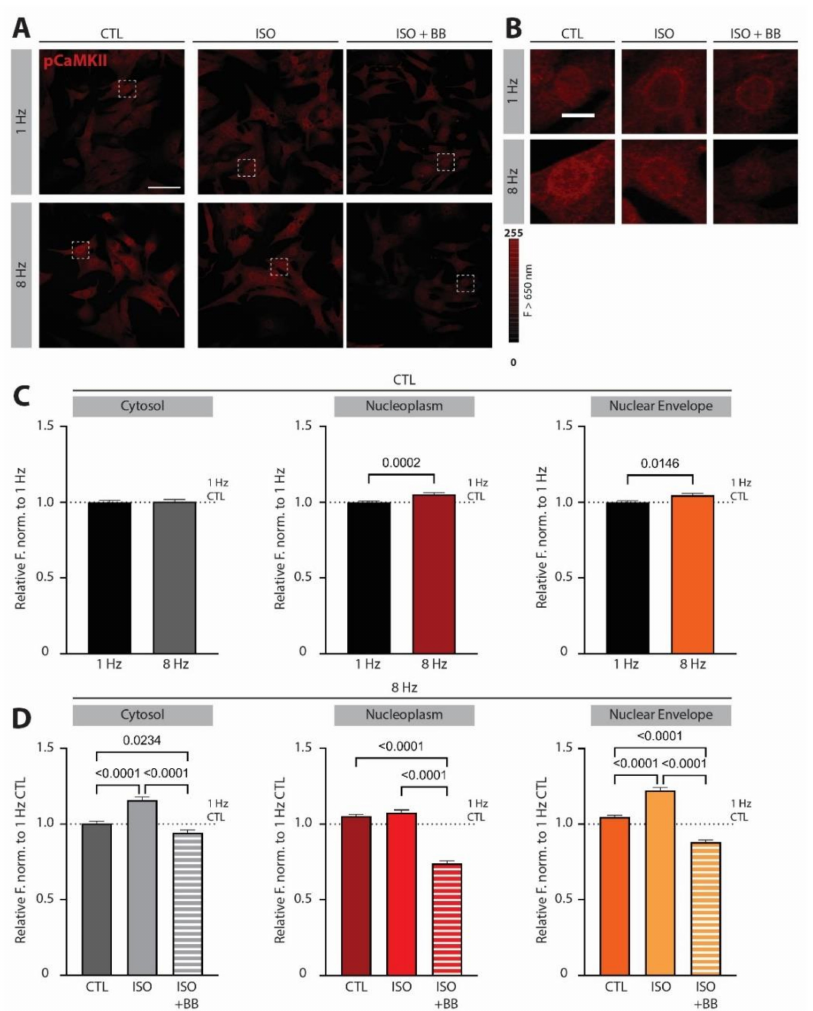
Figure 2. β -adrenergic signaling potentiates CaMKII activation on subcellular Ca 2+ stores in neonatal rat ventricular cardiomyocytes (NRVCMs) under conditions of tachypacing. ( A ) Rep- resentative fluorescent images of NRVCMs immunostained against phospho-CaMKII (pCaMKII) exposed to 3 h of either low pacing (1 Hz) or tachycardic pacing (8 Hz) frequency under control condi- tions (CTL), β -adrenergic stimulation with isoprenaline (ISO) or β -adrenergic stimulation following 1 h preincubation with β -blocker propranolol (ISO + BB). Scale bar indicates 50 µ m. ( B ) Magnified nuclei of indicated areas in ( A ). Scale bar indicates 10 µ m. ( C ) Mean fluorescent values of CTL under low pacing frequency (1 Hz) or tachycardia (8 Hz) in cytoplasm, in nucleoplasm and on the nuclear envelope normalized to the 1 Hz CTL signal of the respective compartment. ( D ) Mean fluorescent values of CTL, ISO and ISO + BB conditions at 8 Hz normalized to the CTL at 1 Hz in cytoplasm, in nucleoplasm and on the nuclear envelope. Data are shown as mean ± SEM ( n = 308–415 cells from N = 4 isolations). Indicated p -values were calculated using ( C ) Mann–Whitney test comparing 8 Hz to 1 Hz in the respective compartments or ( D ) Kruskal–Wallis test comparing normalized CTL, ISO and ISO + BB levels at 8 Hz in the respective